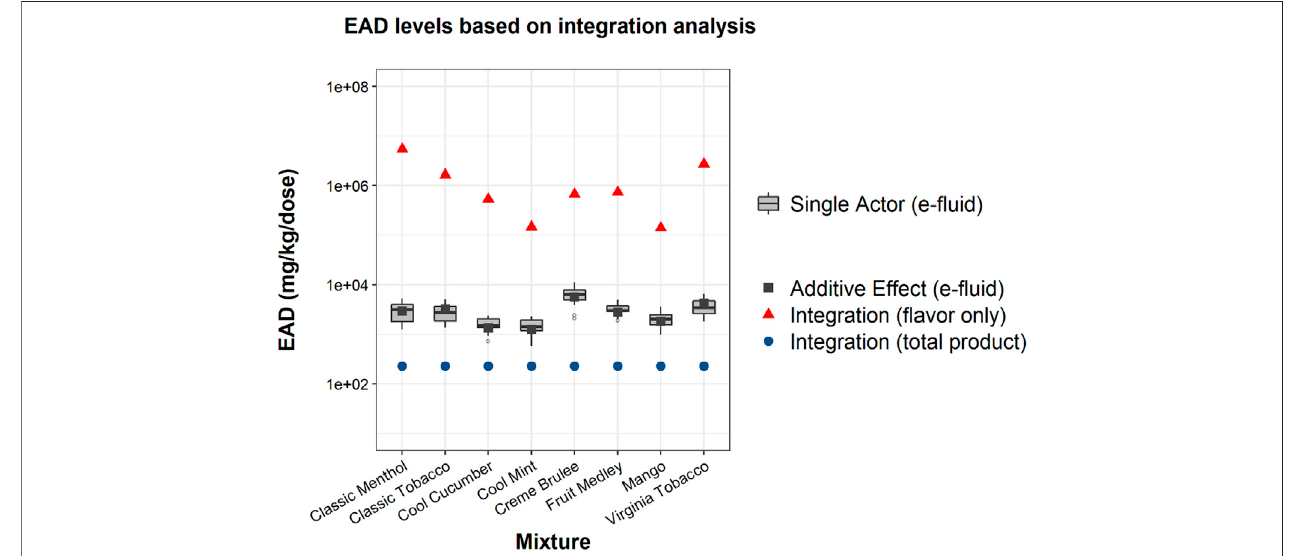
FIGURE 4 | EAD predictions for each fl avor using the ingredient integration analysis based on the geometric mean in vitro cytotoxicity assay AC50 from the HTS data for individual ingredients. This fi gure compares integrationanalysis results under different scenarios(red and blue points) to the e-liquid mixture results presented in Figure1 (graypointsandboxplots).Bluecircularpointsshowpredictionsfortotalproduct,whileredtrianglepointsshowpredictionsfor fl avoringredientsonly.Notethat for this analysis ingredients that were inactive in cytotoxicity assays were excluded ( Supplementary Table S3 ); nicotine, BA, and VG were among the inactive ingredients. The grey boxplots show the results of the single actor analysis for each e-liquid using the MTT assay for comparison, while the grey square points show the additive effect results.